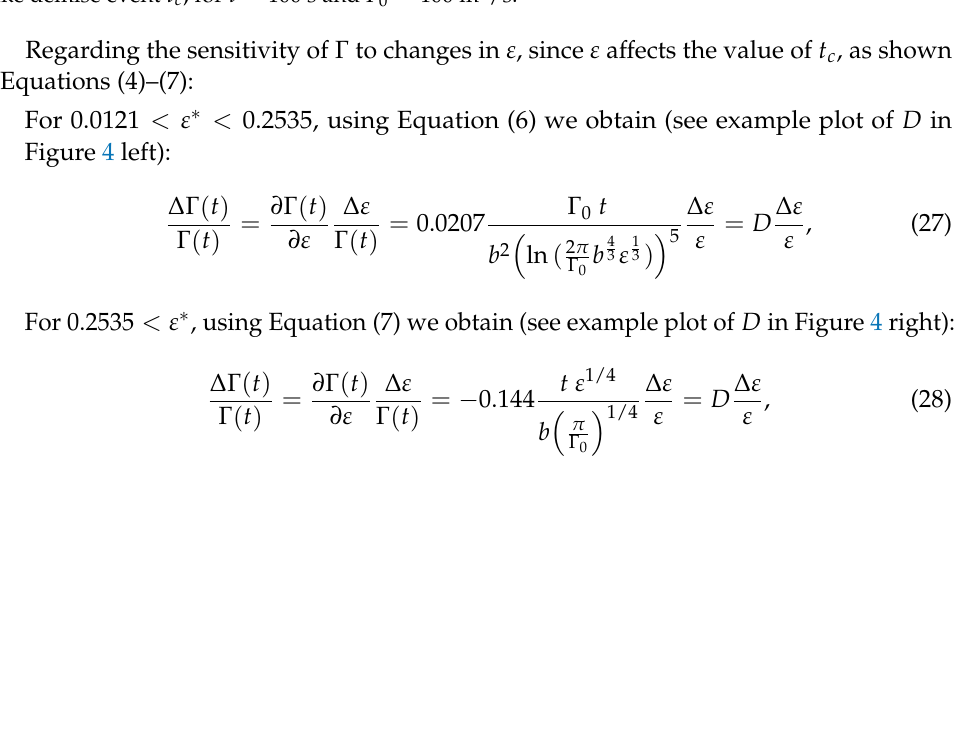
Figure 4. Parameter 𝐷 vs. eddy dissipation rate (EDR), for 𝑡 = 100 s, wing span 𝑏 = 79.75 m, and Γ 0 = 500 and 800 m 2 /s, from ( left ) Equation (27) and ( right ) Equation (28). When analyzing the WV sink rate 𝑤 𝑊𝑉 , from Equations (3) and (11):